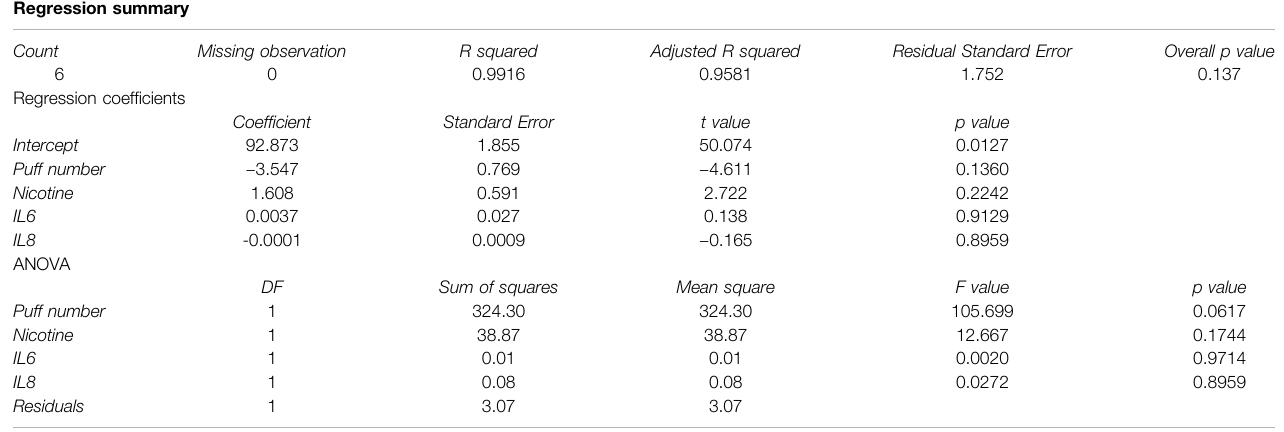
TABLE 1 | Multiple Linear regression analysis ACE2 expression vs puff number, nicotine, IL6, and IL8. Regression summary